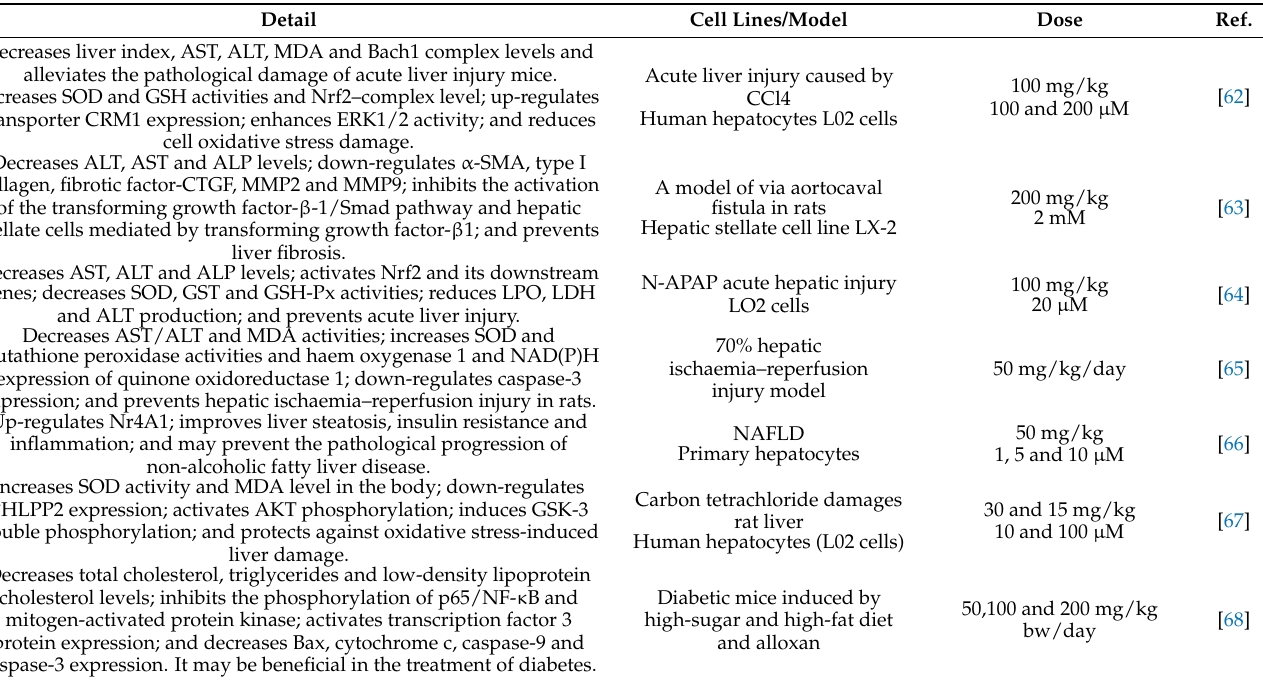
Table 4. Hepatoprotective Activity of Hyperoside.